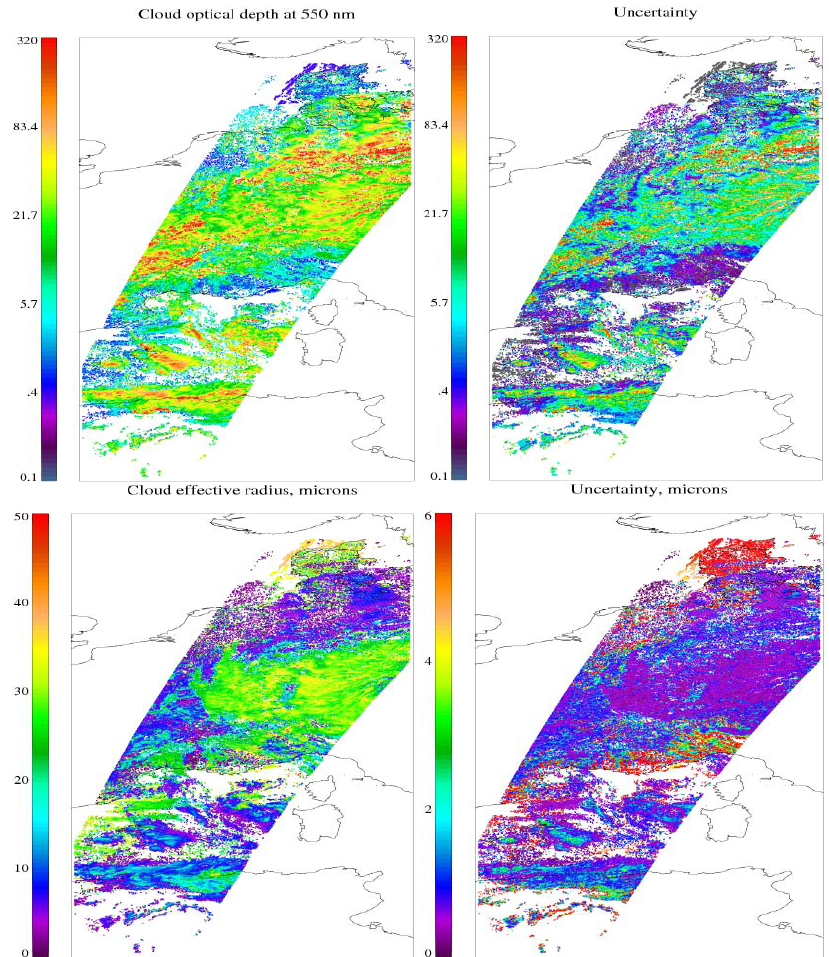
Fig. 7. Cloud optical depth and error on cloud optical depth Cloud effective radius and error on cloud effective radius for the image of Fig. 6, 10 November 1999.